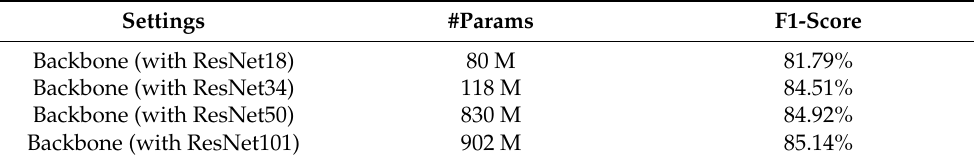
Table 1. Performance and parameters comparison of ResNet series models.